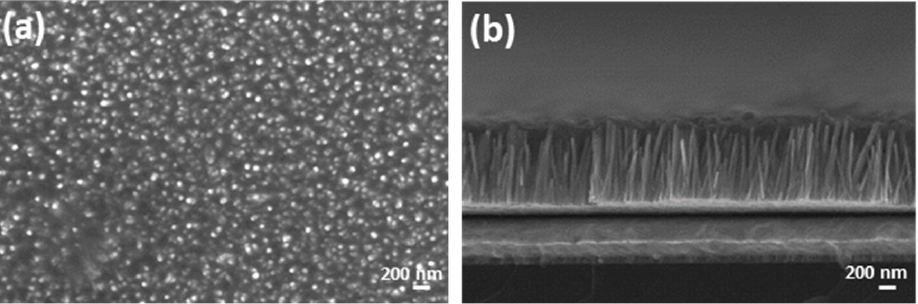
Figure 2. ZnO nanowires after PMMA deposition, ( a ) top view and ( b ) side view of as-grown, vertically orientated ZnO NW arrays.